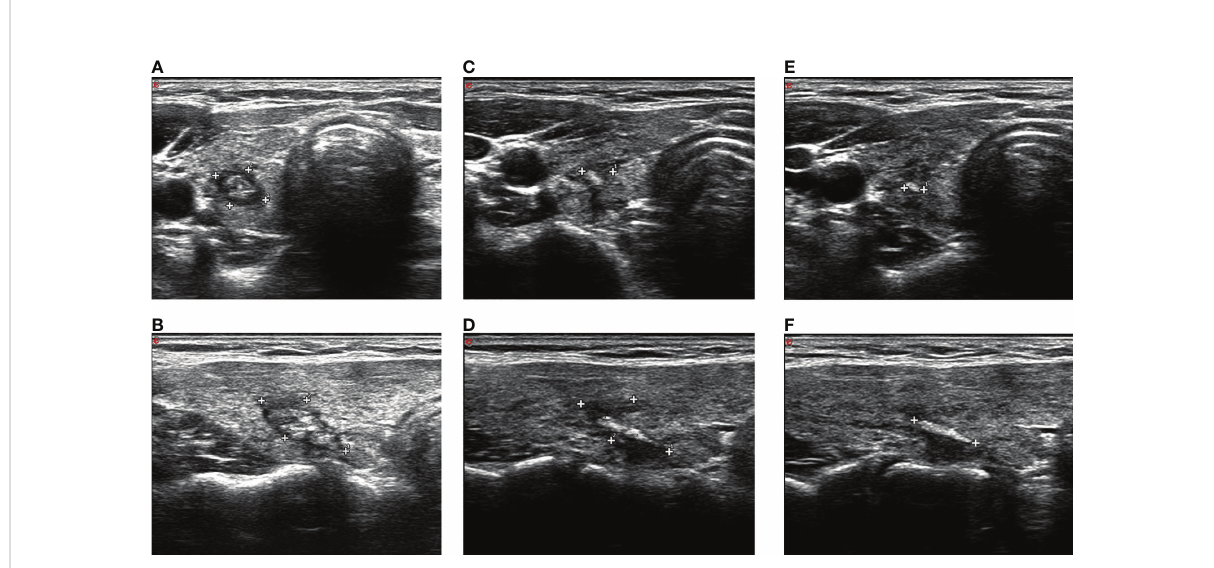
FIGURE 4 A The ablation lesion (caliper in A, transverse plane; caliper in B , longitudinal plane) shrank gradually after PLA 3 months. The ablation lesion (caliper in C , transverse plane; caliper in D , longitudinal plane) shrank further. The ablation lesion (caliper in E , transverse plane; caliper in F , longitudinal plane) shows scar-like changes after PLA 42 months.